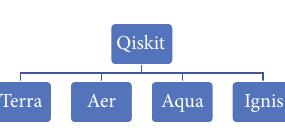
Figure 1: The Qiskit framework and its